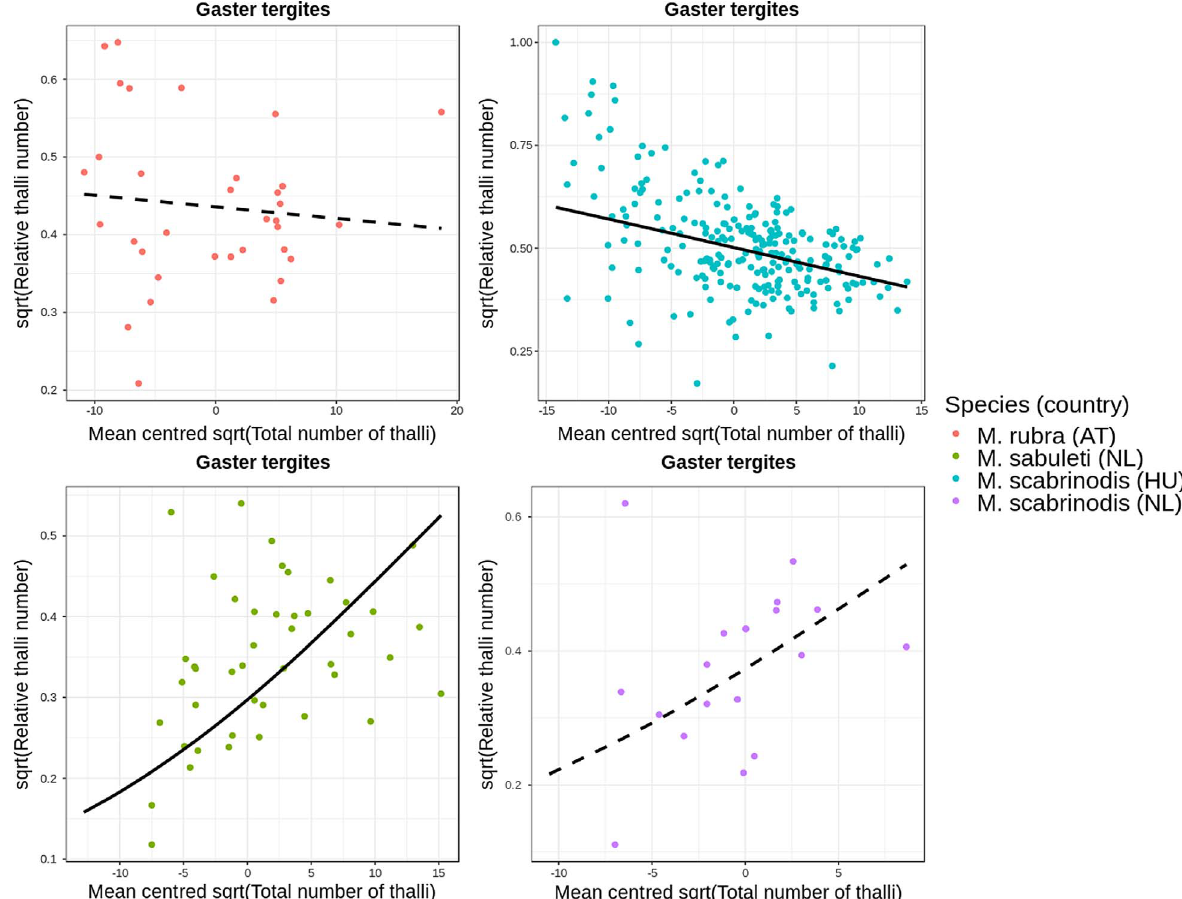
Figure 8. Association between total number of thalli and relative number of thalli on the gaster tergites (zeros excluded, n = 336). Black curves are regression lines from the fi tted model: solid and dashed lines represent signi fi cant and non-signi fi cant associations, respectively.